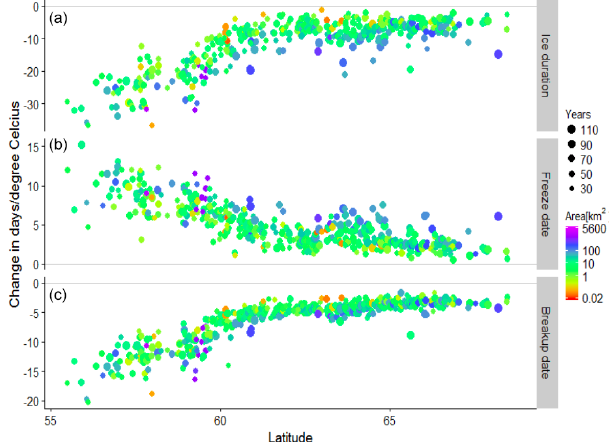
Figure 6. Change (in days per 1 ◦ C increase in air temperature) in (a) ice duration relative to annual mean temperature, (b) freeze date relative to mean temperature from October–December, and (c) break-up date relative to mean temperature from March–May based on the linear regression of air temperature and observation date each year for each lake. For the freeze and break-up, negative (positive) values represent earlier (later) dates with increasing tem- perature. Marker colors represent the area of the lake, while marker sizes denote the number of years with both lake ice and temperature